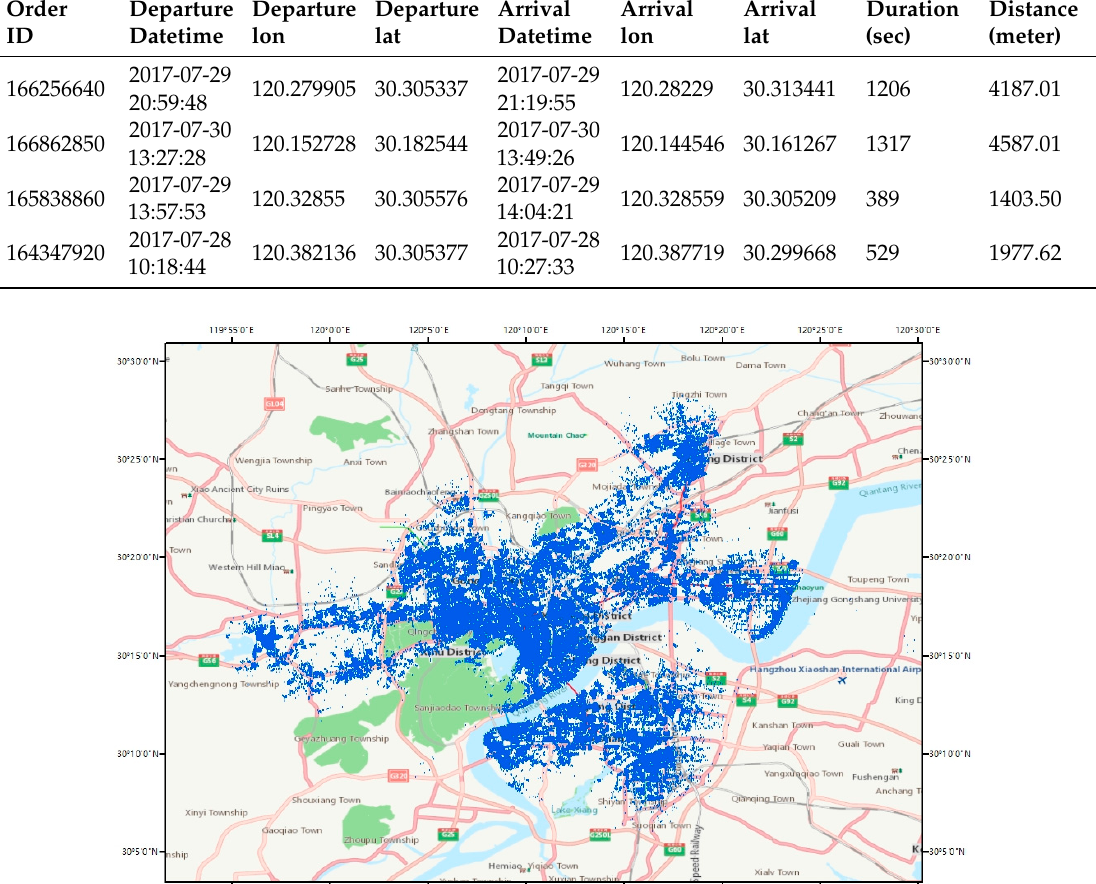
Table 1. A small subset of the delivery origin-destination (OD) dataset. Each row corresponds to an occupied delivery order.